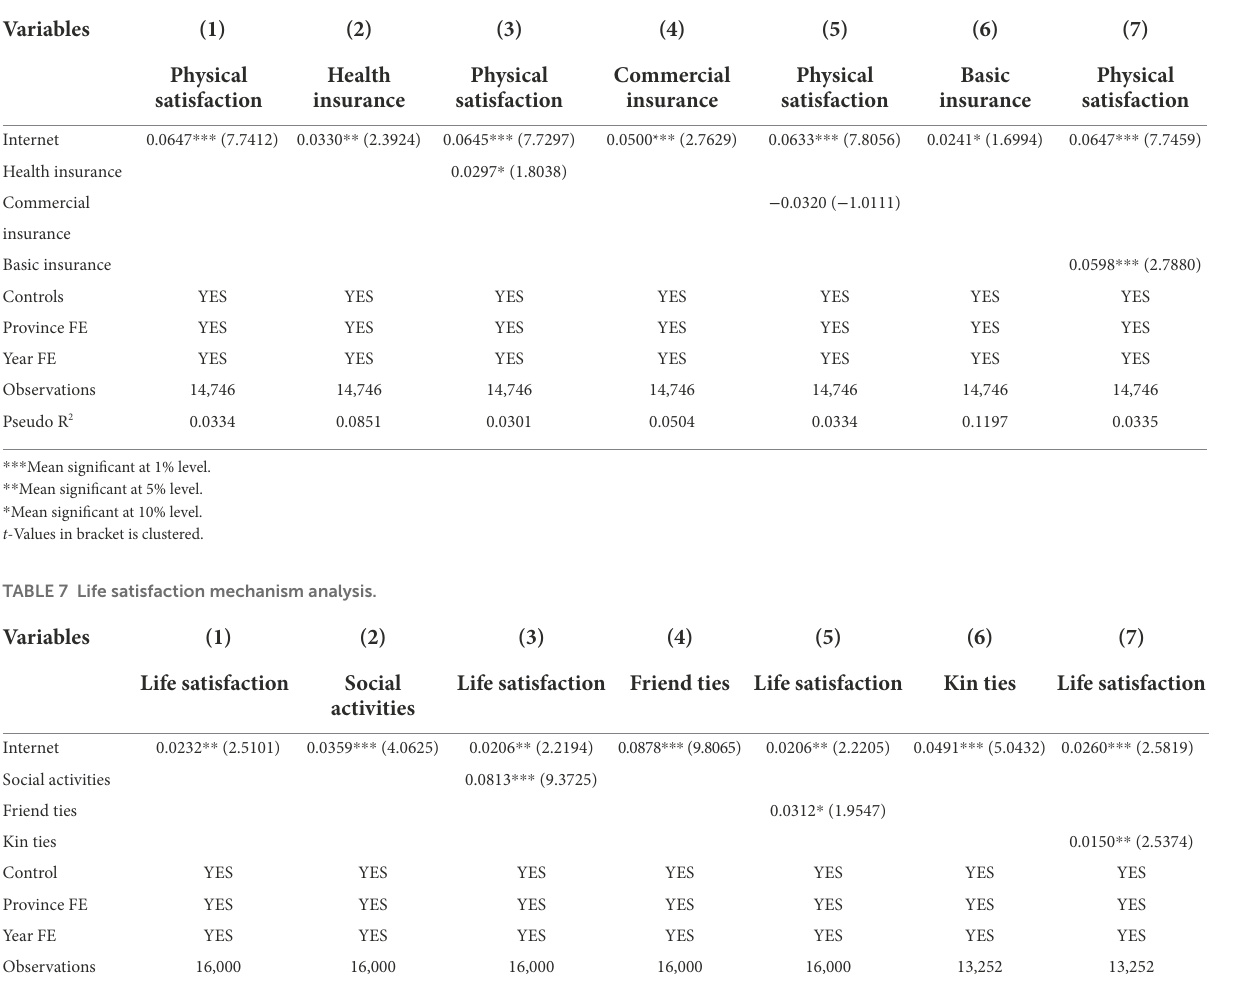
TABLE 6 Physical satisfaction mechanism analysis.